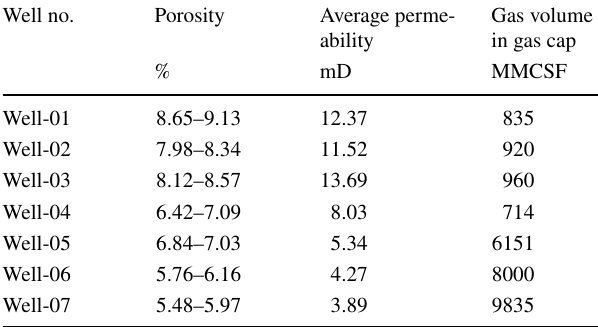
Table 1 Rock and reservoir characteristics Well